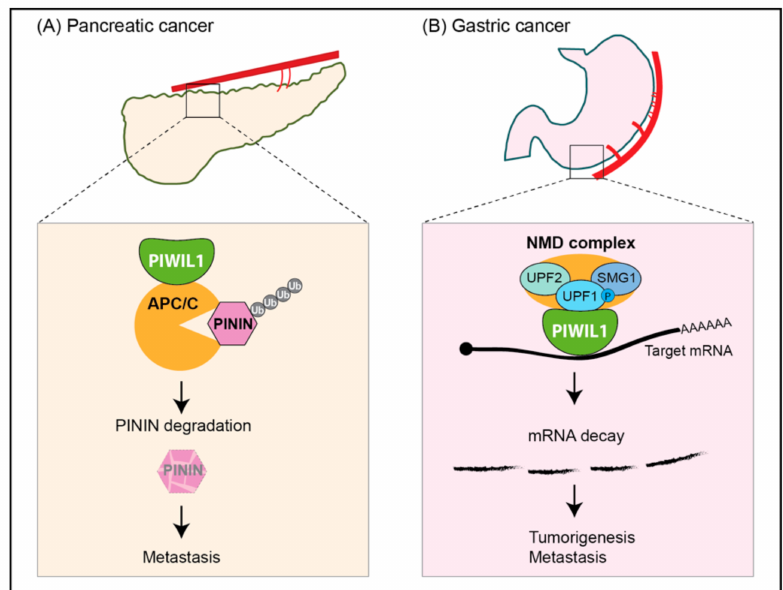
Figure 4. piRNA-independent regulation of PIWI protein. ( A ) In pancreatic cancer, unloaded PIWIL1 interacts with the anaphase-promoting complex/cyclosome (APC/C) E3 complex and acts as a co- activator to target a cell adhesion-related protein, PININ [59]. ( B ) In gastric cancer, unloaded PIWIL1 degrades many target RNAs via the recruitment of UPF1-mediated nonsense-mediated mRNA decay (NMD) components